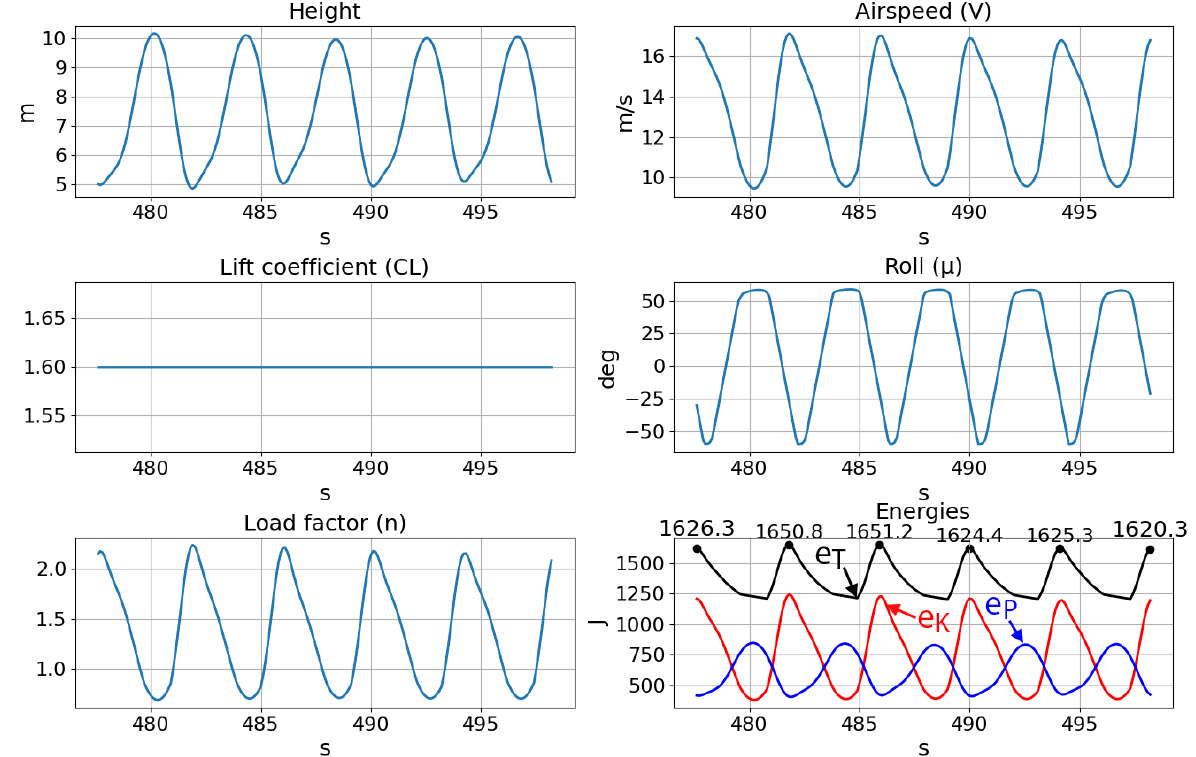
Figure 9. Trajectory trace of the dynamic soaring albatross